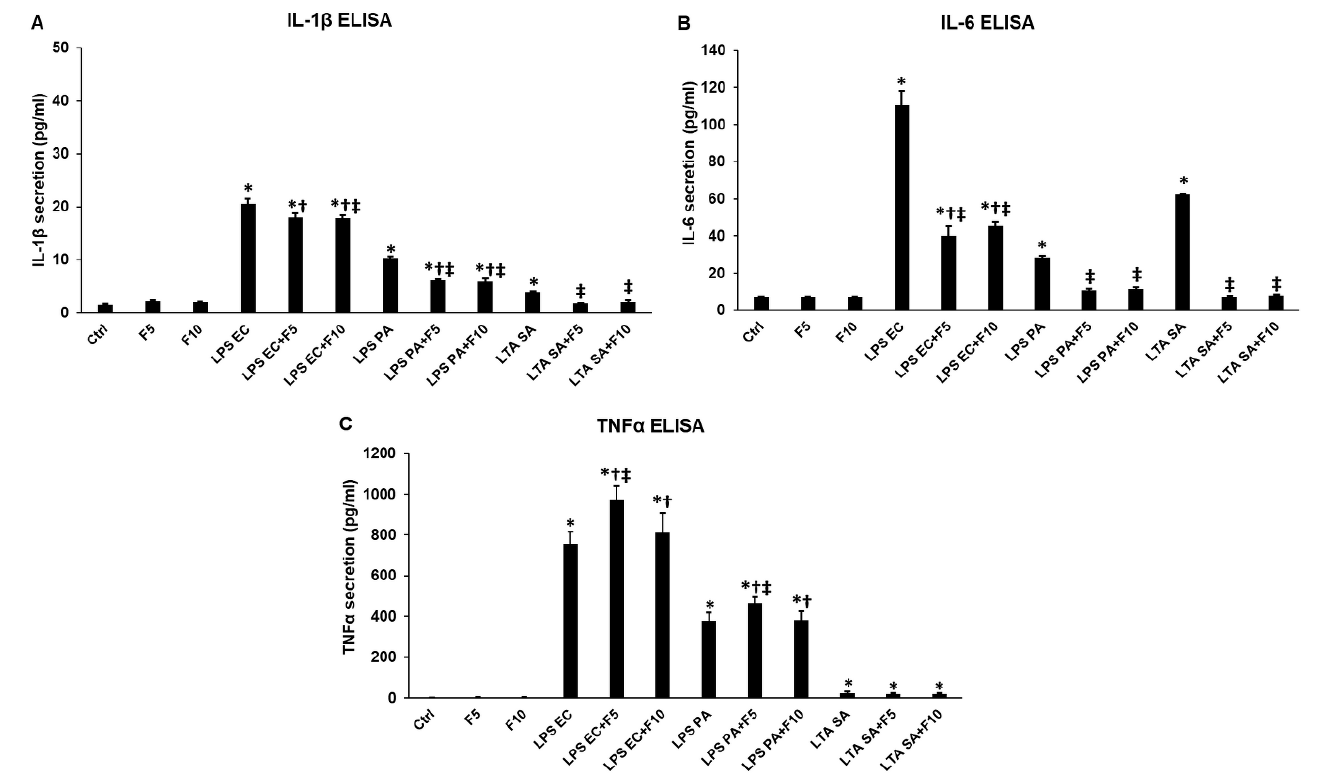
Figure 2 . ELISA measurement of IL-1 β ( A ), IL-6 ( B ) and TNF α ( C ) pro-inflammatory cytokine secretion of E. coli or P. aeruginosa LPS and S. aureus LTA and/or fractalkine-treated THP-1 cells. Pro- inflammatory cytokine secretions were determined using human IL-1 β , IL-6 and TNF α specific ELISA kits according to the manufacturer’s instructions. The bars represent mean values and error bars represent standard deviation (SD) for three independent determinations ( n = 3). ELISA measurements were made in triplicate in each independent experiment. Statistical significance was determined by two-way ANOVA (considering the number of the categorical variables) followed by Scheffe’s post hoc test. Asterisks indicate p < 0.05 compared to the control. Cross marks p < 0.05 compared to the fractalkine treatment. Double cross shows p < 0.05 compared to the LPS or LTA treatments, respectively. Abbreviations : F5—fractalkine 5 ng/mL; F10—fractalkine 10 ng/mL; LPS EC— E. coli lipopolysaccharide; LPS PA— P. aeruginosa lipopolysaccharide; LTA SA— S. aureus lipoteichoic